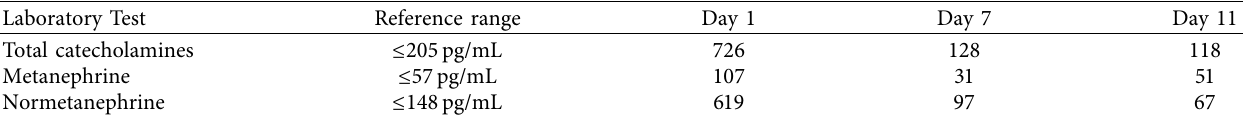
Figure 1: Blood pressure trends during second admission. Table 1: Selected laboratory results during second